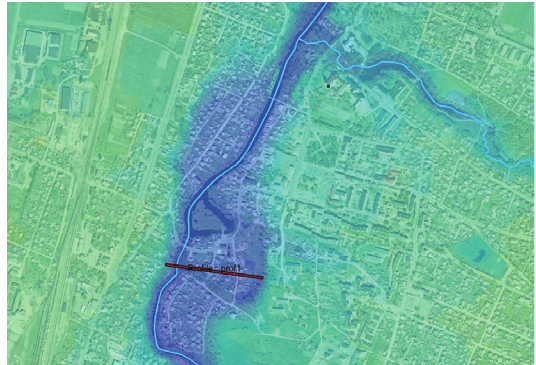
Fig. 5. Overlay of modeled water surface and area topography on the aerial photograph of the Akmena-Danė river basin area in the central part of Kretinga Town (grid 5 m). Potential flood risk zones are not shadowed